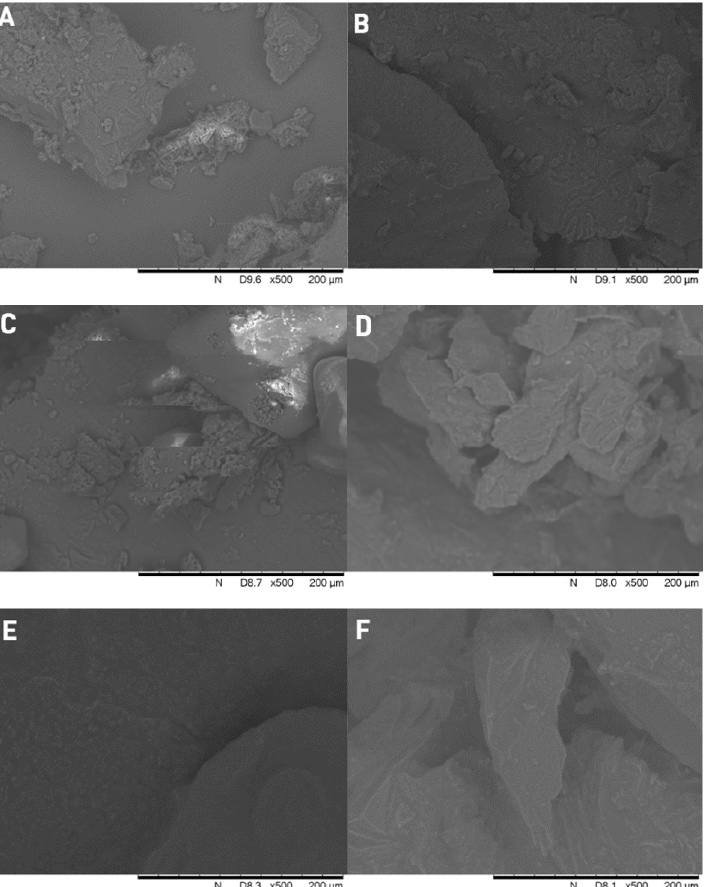
Figure 5. Scanning electron microscope images of PEG 2000 physical mixture ( A ) and solid dispersion ( B ); PEG 1500 physical mixture ( C ) and solid dispersion ( D ); PEG 1000 physical mixture ( E ) and solid dispersion ( F ).